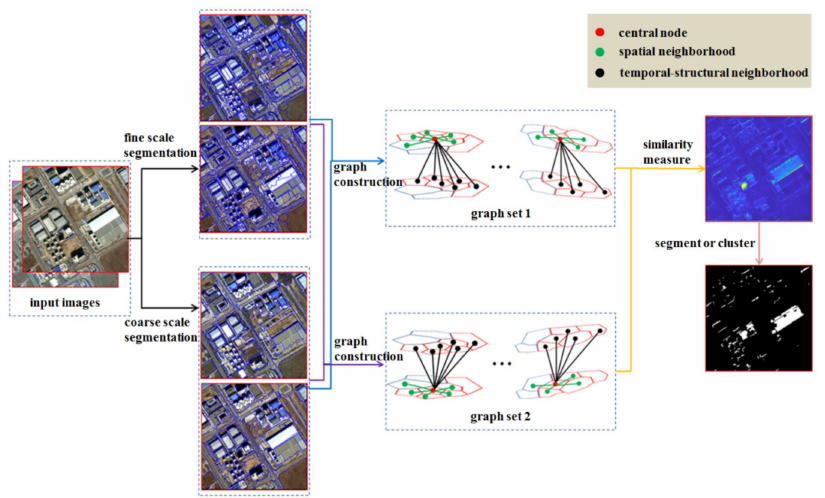
Figure 1. Flowchart of the proposed